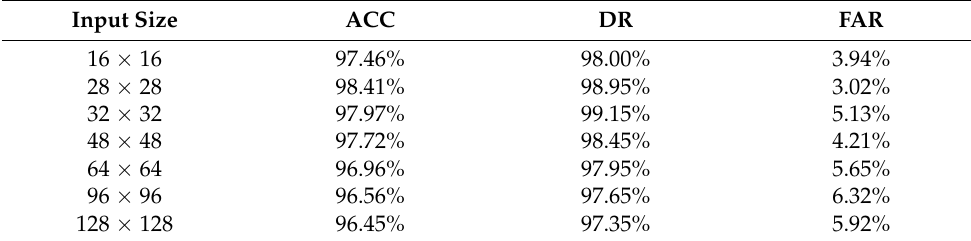
Table 6. Results of binary classification with different input sizes.